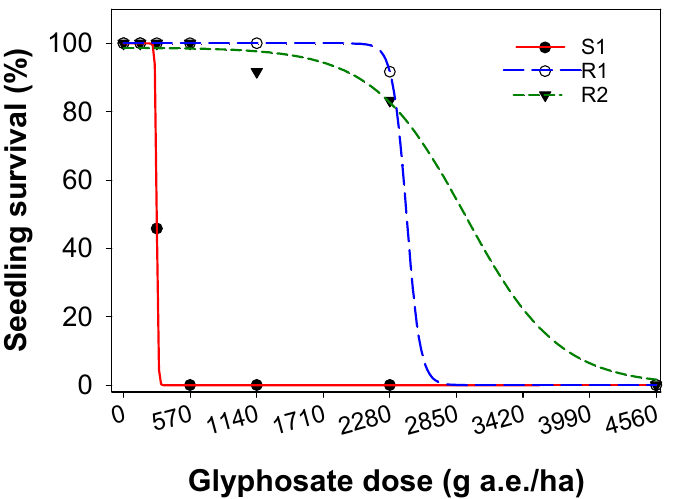
Figure 2. Effect of glyphosate dose on survival (%) of a glyphosate-susceptible (S1) and two glyphosate-resistant (R1 and R2) biotypes of sweet summer grass. A three-parameter sigmoid model fitted to the survival data.